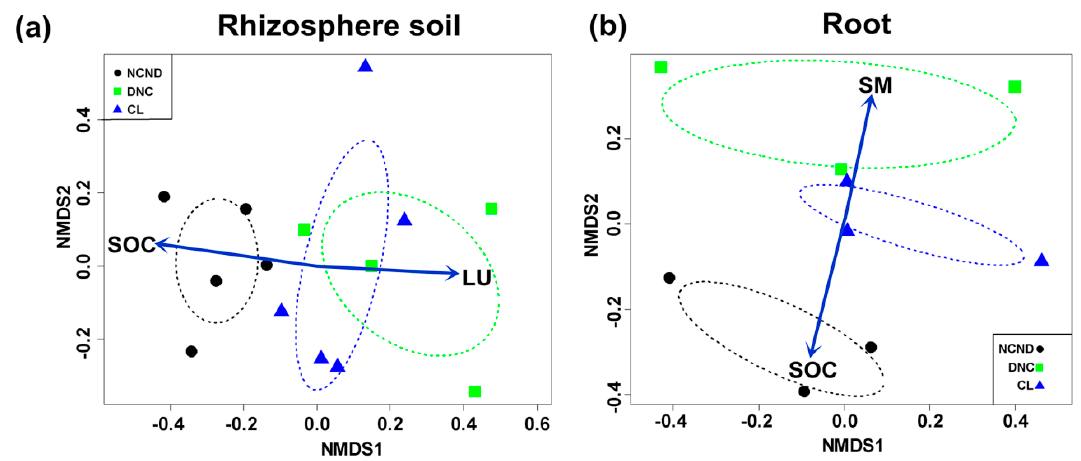
Figure 4. Nonmetric multidimensional scaling (NMDS) ordinations of arbuscular mycorrhizal fungus (AMF) community composition based on the Bray-Curtis dissimilarity in both the rhizosphere soils ( a ) and roots ( b ) of C. dactylon along the drawdown zone of Three Gorges Reservoir. The three contrasting land-use types were fitted as centroids onto the NMDS graph (stress ( a ) = 0.131;